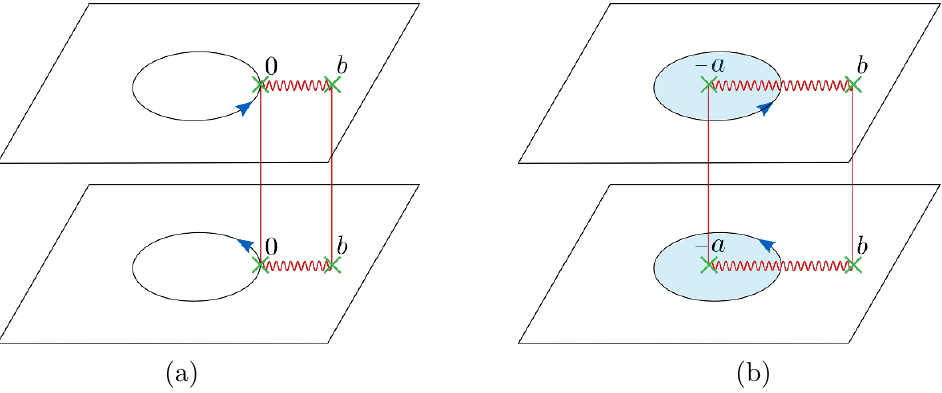
Figure 11 . (a) We have a (cid:13)at space (cid:12)eld theory on the exterior of the disk. The disk is hollow in this picture, and will be (cid:12)lled in with gravitational con(cid:12)gurations subject to the boundary conditions on the unit circle. This boundary is connected into a single long circle n times longer than the original one. This is indicated by the blue arrow which tells you how to go around the cut. (b) The disk is (cid:12)lled in with a gravitational con(cid:12)guration with the topology of a disk which ends on the elongated unit circle. This con(cid:12)guration can be represented by adding a branch point inside. Note that the local geometry at the branch point \ (cid:0) a " is completely smooth.